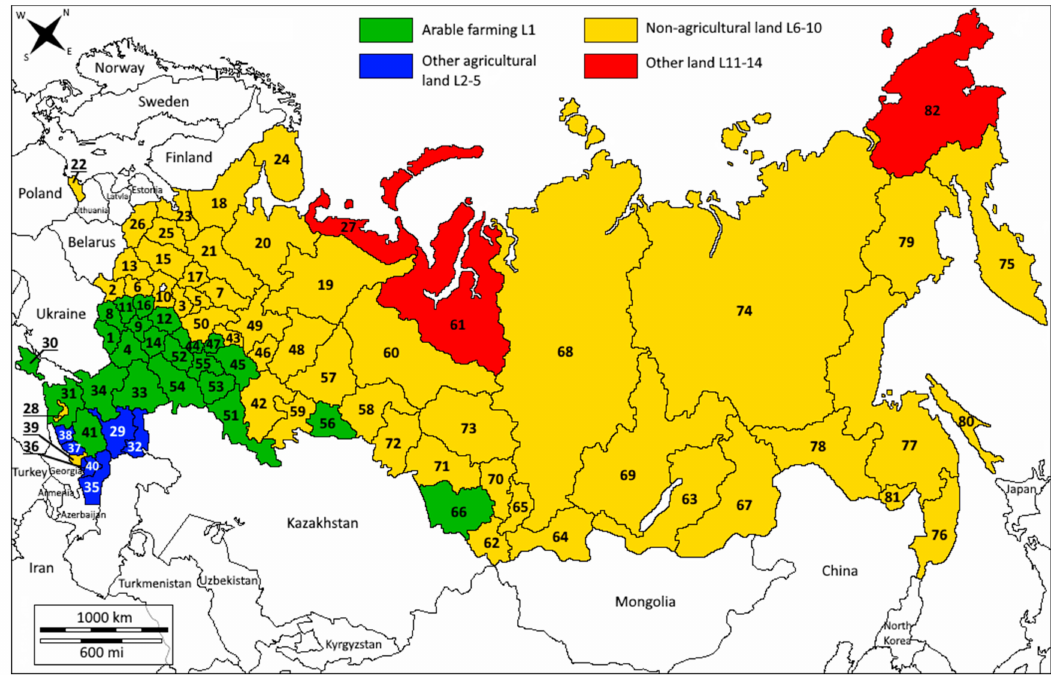
Figure 2. Spatial distribution of agricultural lands in Russia. Note: 1 = Belgorod; 2 = Bryansk; 3 = Vladimir; 4 = Voronezh; 5 = Ivanovo; 6 = Kaluga; 7 = Kostroma; 8 = Kursk; 9 = Lipetsk; 10 = Moscow Oblast; 11 = Orel; 12 = Ryazan; 13 = Smolensk; 14 = Tambov; 15 = Tver; 16 = Tula; 17 = Yaroslavl; 18 = Karelia; 19 = Komi; 20 = Arkhangelsk; 21 = Vologda; 22 = Kaliningrad; 23 = Leningrad; 24 = Murmansk; 25 = Novgorod; 26 = Pskov; 27 = Nenets; 28 = Adygeya; 29 = Kalmykia; 30 = Crimea; 31 = Krasnodar; 32 = Astrakhan; 33 = Volgograd; 34 = Rostov; 35 = Dagestan; 36 = Ingushetia; 37 = Kabardino-Balkaria; 38 = Karachaevo-Cherkessia; 39 = North Osetia-Alania; 40 = Chechnya; 41 = Stavropol; 42 = Bashkortostan; 43 = Mari El; 44 = Mordovia; 45 = Tatarstan; 46 = Udmurtia; 54 = Saratov; 55 = Ulyanovsk; 56 = Kurgan; 57 = Sverdlovsk; 58 = Tyumen; 59 = Chelyabinsk; 60 = Khanty-Mansi; 61 = Yamal-Nenets; 62 = Altay Republic; 63 = Buryatia; 64 = Tyva; 65 = Khakasia; 66 = Altay; 67 = Zabaikalsk; 68 = Krasnoyarsk; 69 = Irkutsk; 70 = Kemerovo; 71 = Novosibirsk; 72 = Omsk; 73 = Tomsk; 74 = Sakha Yakutia; 75 = Kamchatka; 76 = Primorye; 77 = Khabarovsk; 78 = Amur; 79 = Magadan; 80 = Sakhalin; 81 = Jewish AO; 82 = Chukotka. The Republic of Crimea was included in the study due to its current position as a territory under the de-facto control of Russia. This in no way reflects the authors’ attitude to the international status of the area. Source: Authors’